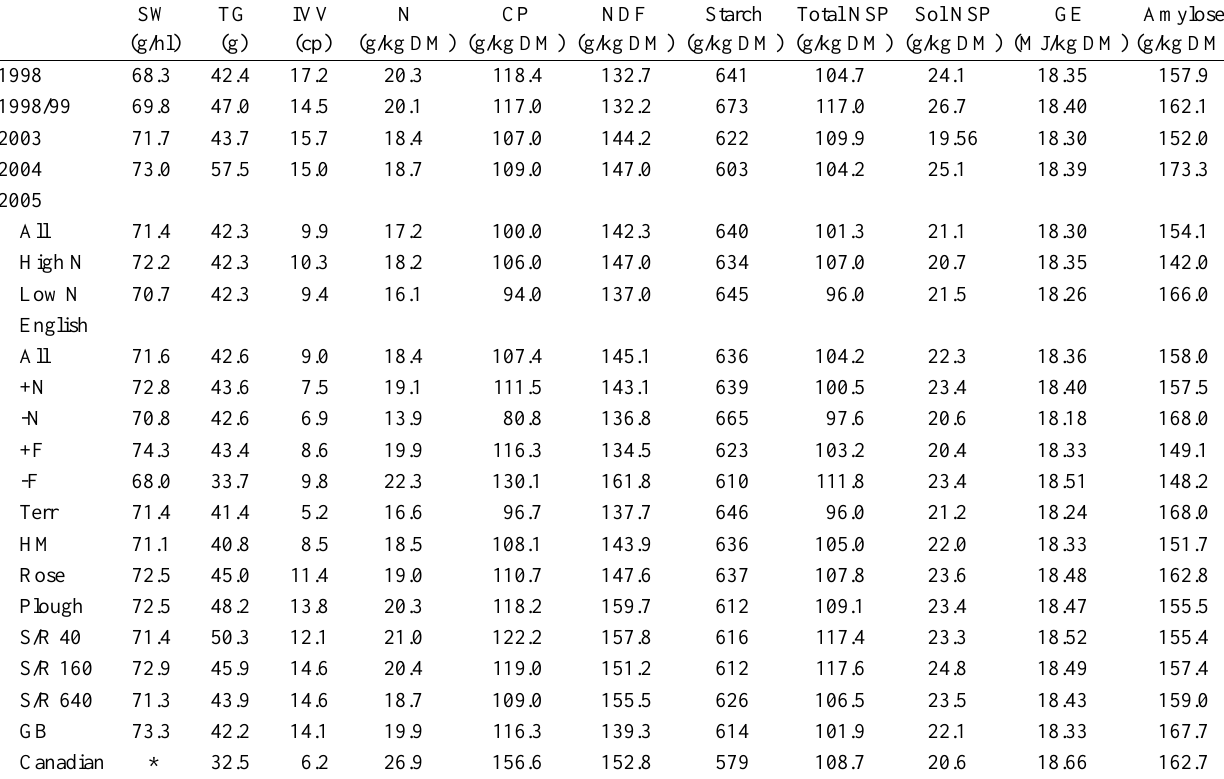
Table 1. Chemical and physical analysis of wheats as grouped by year of production, location and conditions of growth SW TG IVV N CP (g/hl) (g) (cp) (g/kg DM) 1998 68.3 69.8 2004